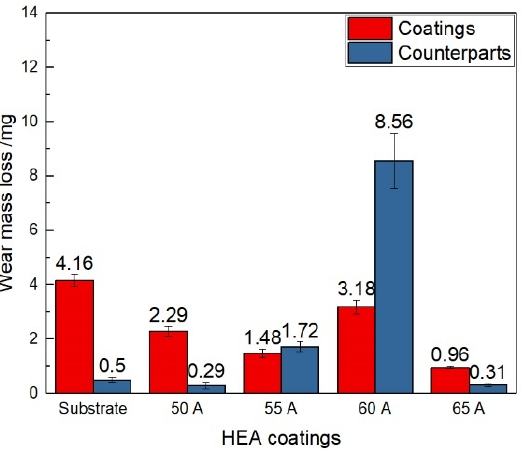
Figure 9. Wear mass loss of the CoCrFeNiMn HEA coatings, CGI substrate and N80 pin counterpart after wear test.